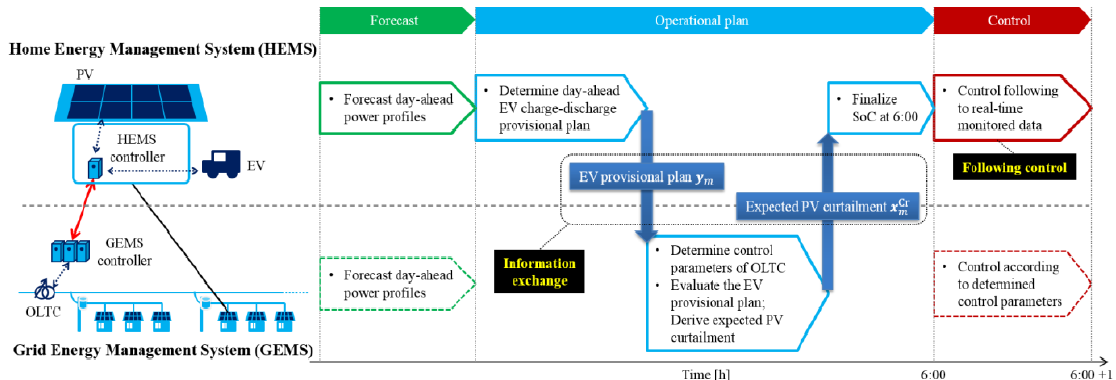
Figure 9. EV charge -Discharge coordination framework.